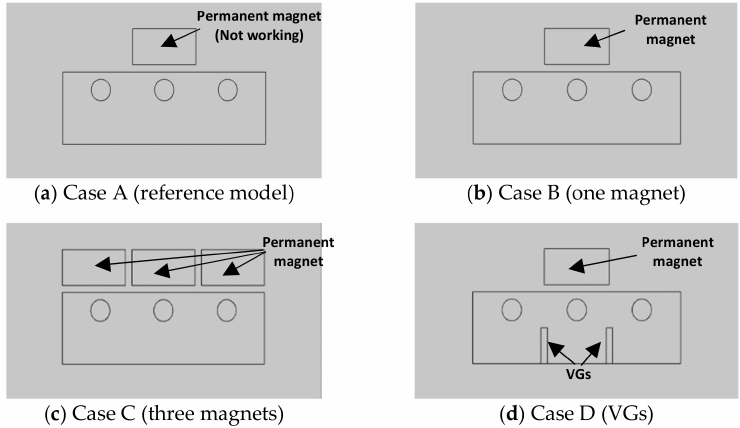
Figure 4. Case classification applied in this study.